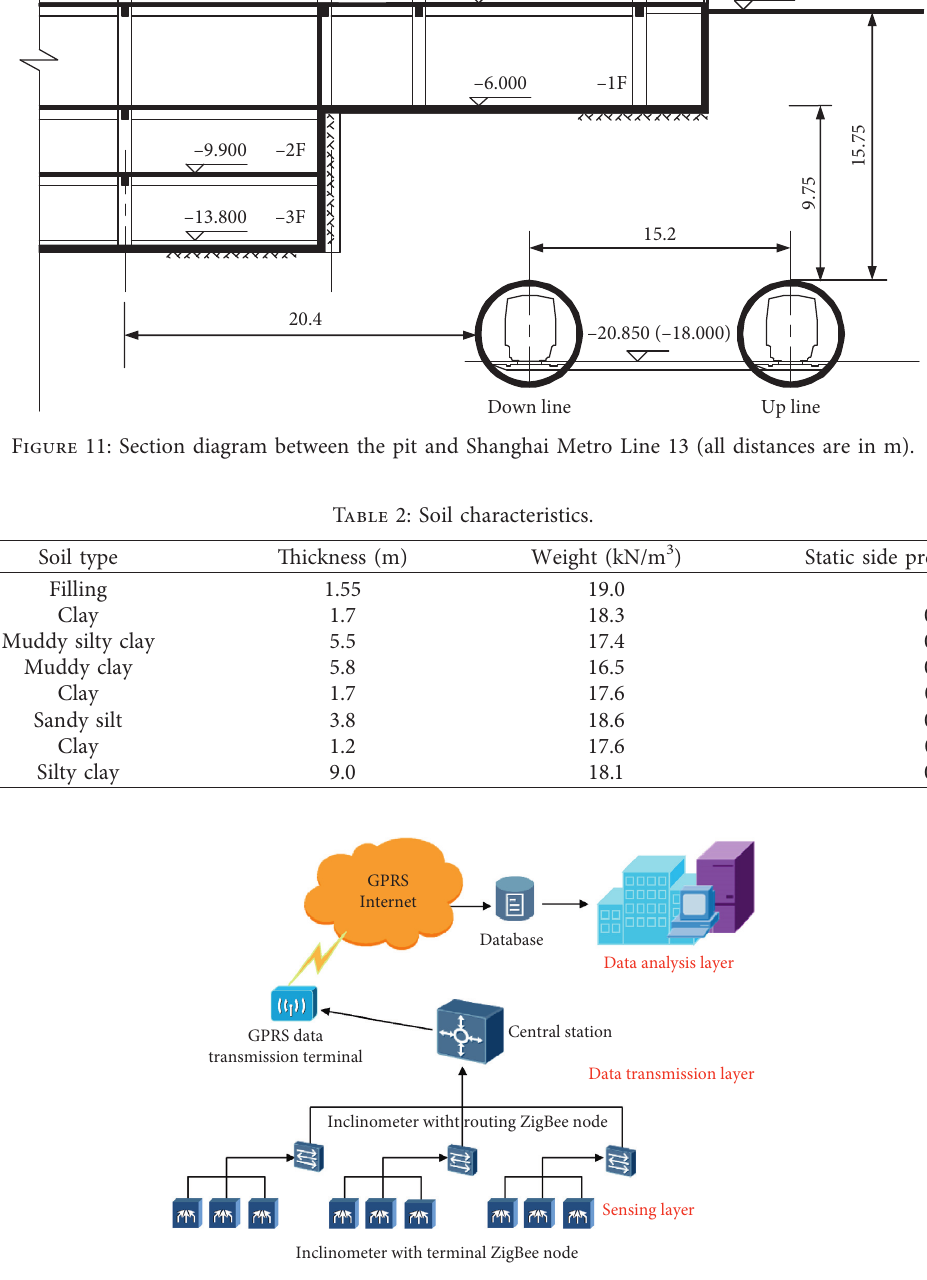
Figure 12: Schematic of the monitoring system